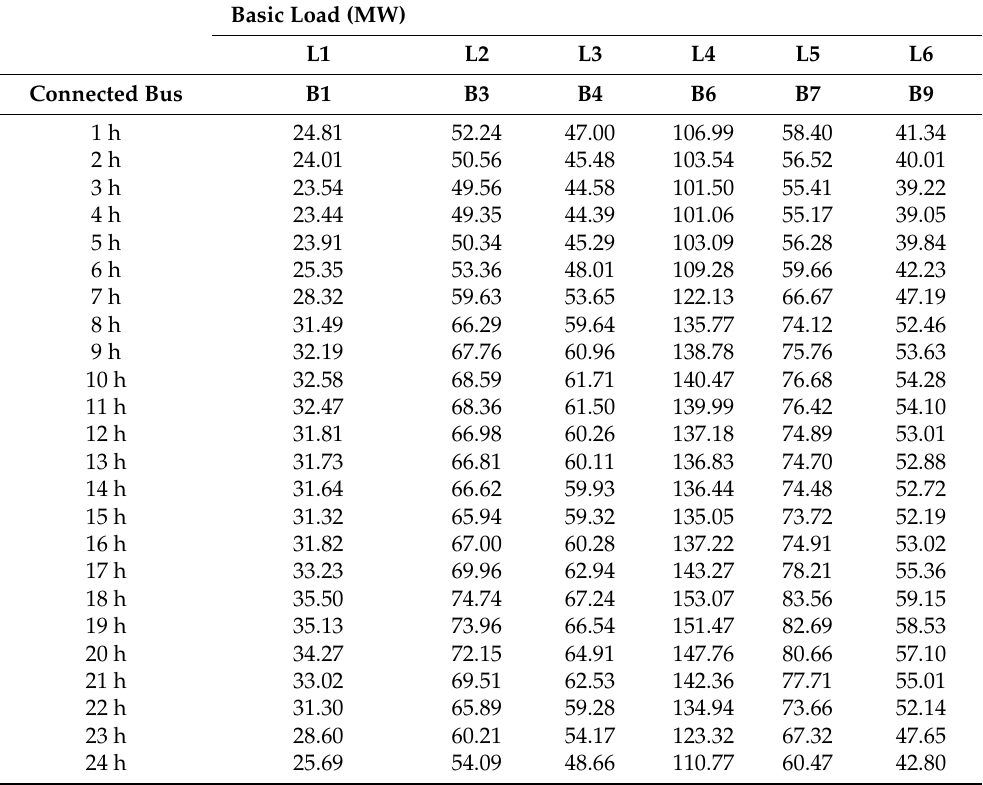
Table A1. Bus system.